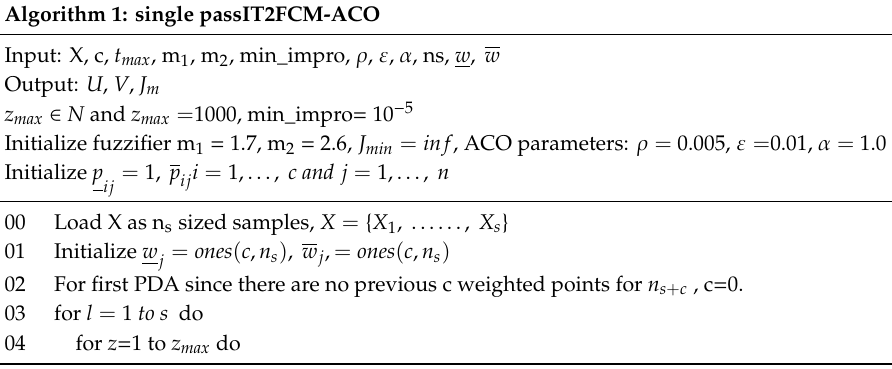
Algorithm 1: single